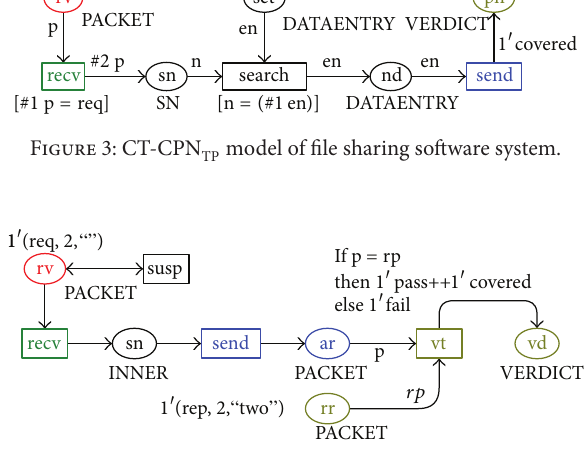
Figure 4: CT-CPN model of file sharing software TC